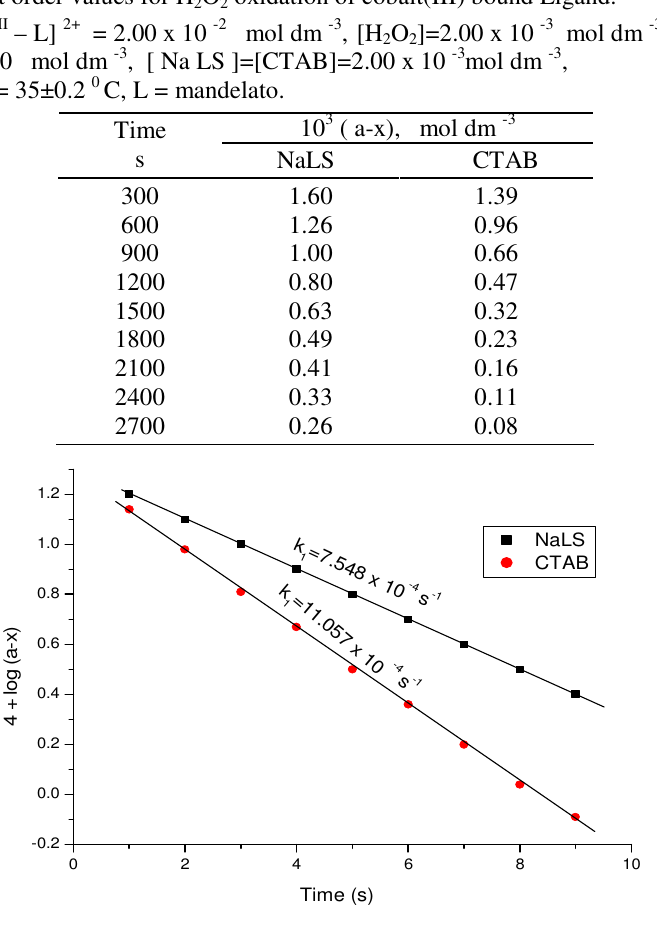
O oxidation of cobalt(III) bound Ligand. 2 2